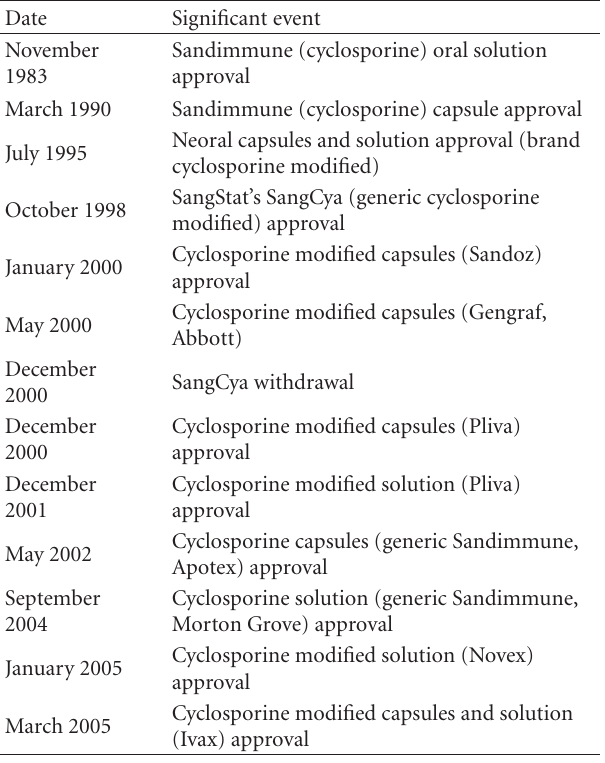
Table 1: Cyclosporine development